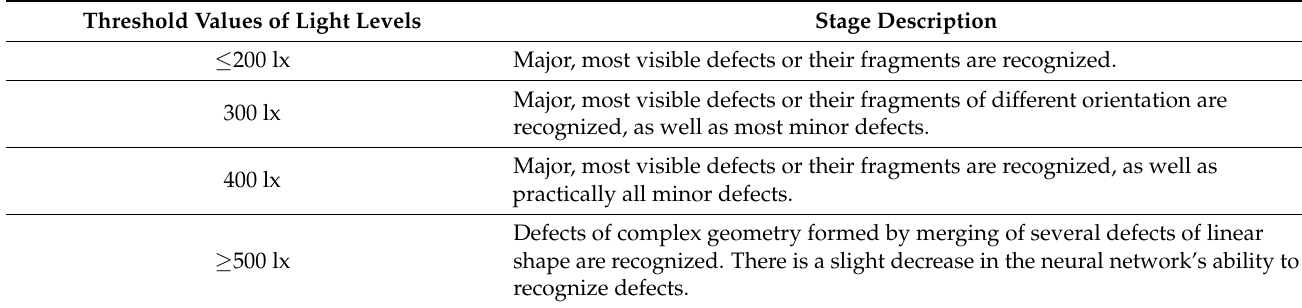
Table 2. Surface defect recognition stages by the neural network. Threshold Values of Light